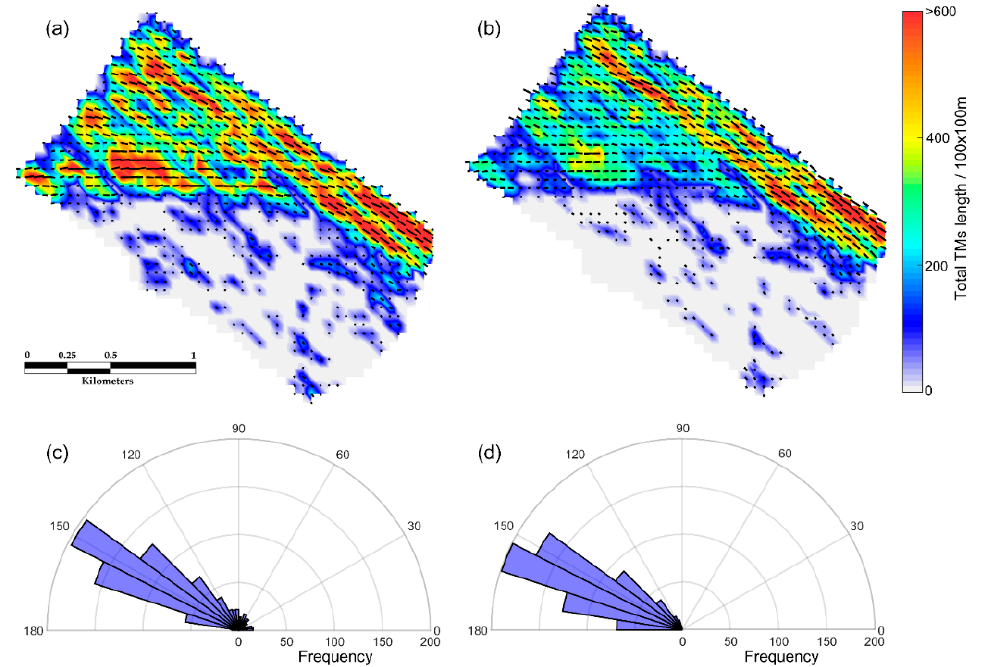
Figure 11. ( a ) A binary image showing the automatically extracted TMs and ( b ) an image depicting the manually digitized TMs (dataset from [24]).